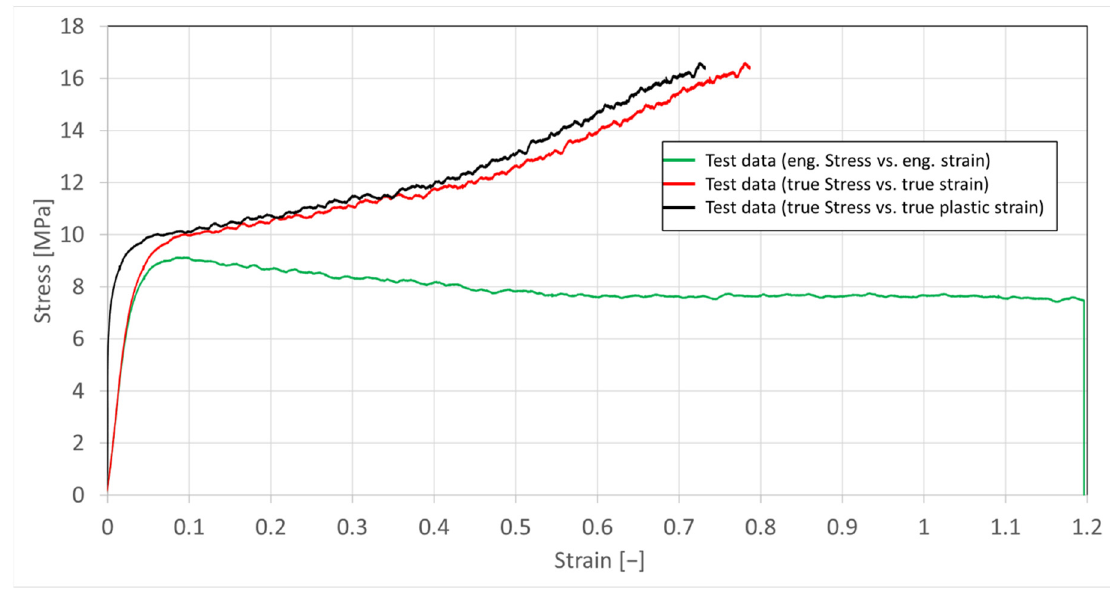
Figure 8. Preparation of the TD test curve from engineering stress vs. engineering strain (green curve), to true stress vs. true strain (red curve) to the true stress vs. true plastic strain (black curve).